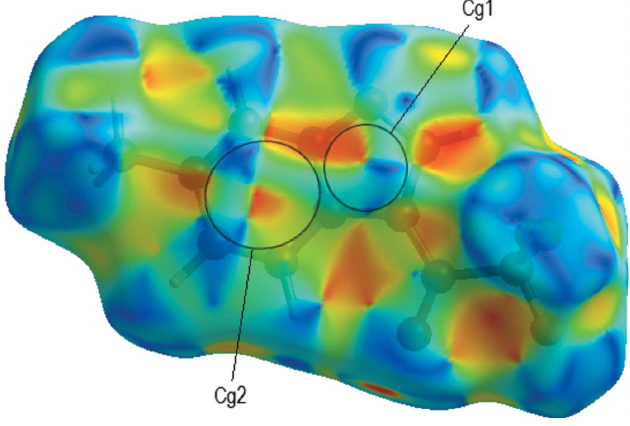
Figure 7 Hirshfeld surface of the title compound plotted over shape-index.